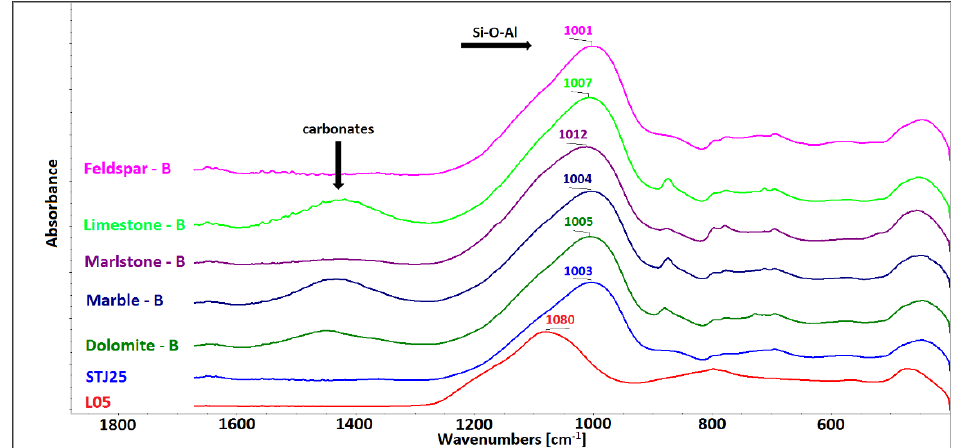
Figure 1. The FTIR-ATR spectra of the initial material (L05) and the resulting geopolymer material (STJ 25, Dolomite-B, Marble-B, Marlstone-B, Limestone-B and Feldspar-B). Table 5. Textural and sorption properties.